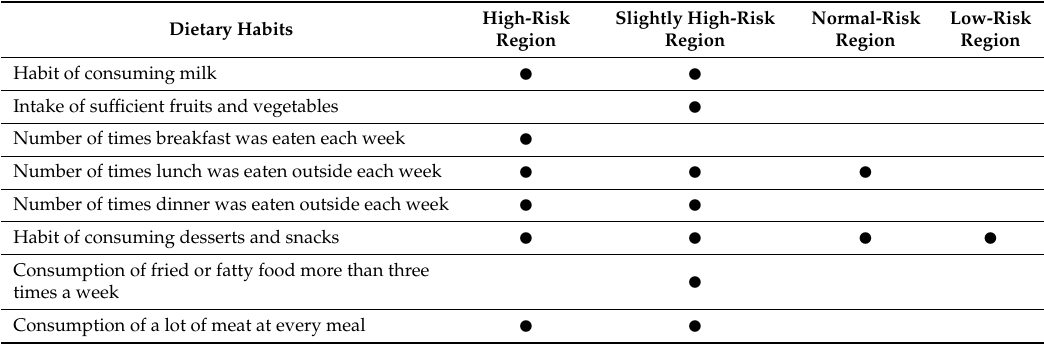
Table 4. Comparison of major risk factors for each group by dietary habits. Dietary Habits